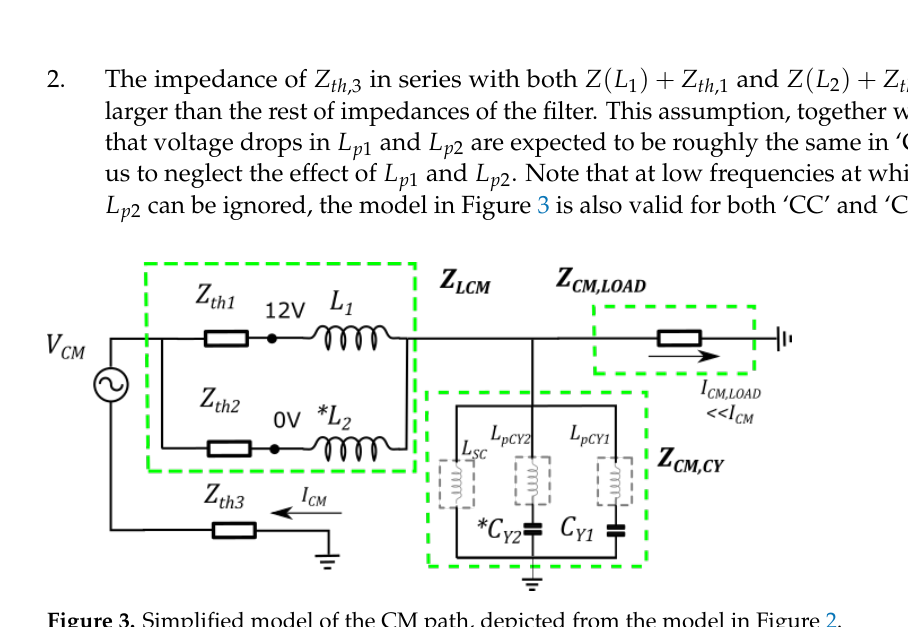
Figure 3. Simplified model of the CM path, depicted from the model in Figure